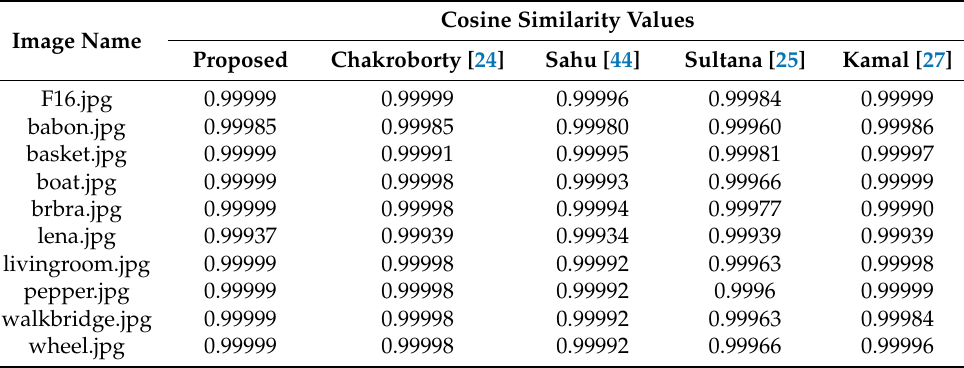
Figure 10. Performance comparison of the proposed scheme with the competing scheme in terms of entropy values. The figure states that the proposed scheme has the lowest entropy values [24,25,27,44]. Table 2. Cosine Similarity values of various schemes.